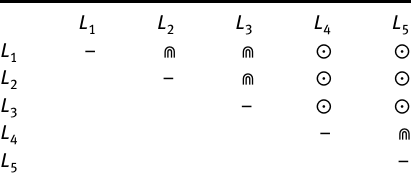
Table 8: Relation matrix of the core, illustrated in Figure 9B, of the substructure (from 800th to 900th nucleotides) PDB_00589.